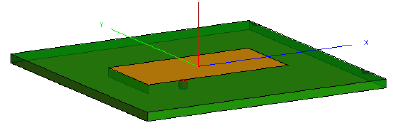
Fig. 1. The antenna radiator model.